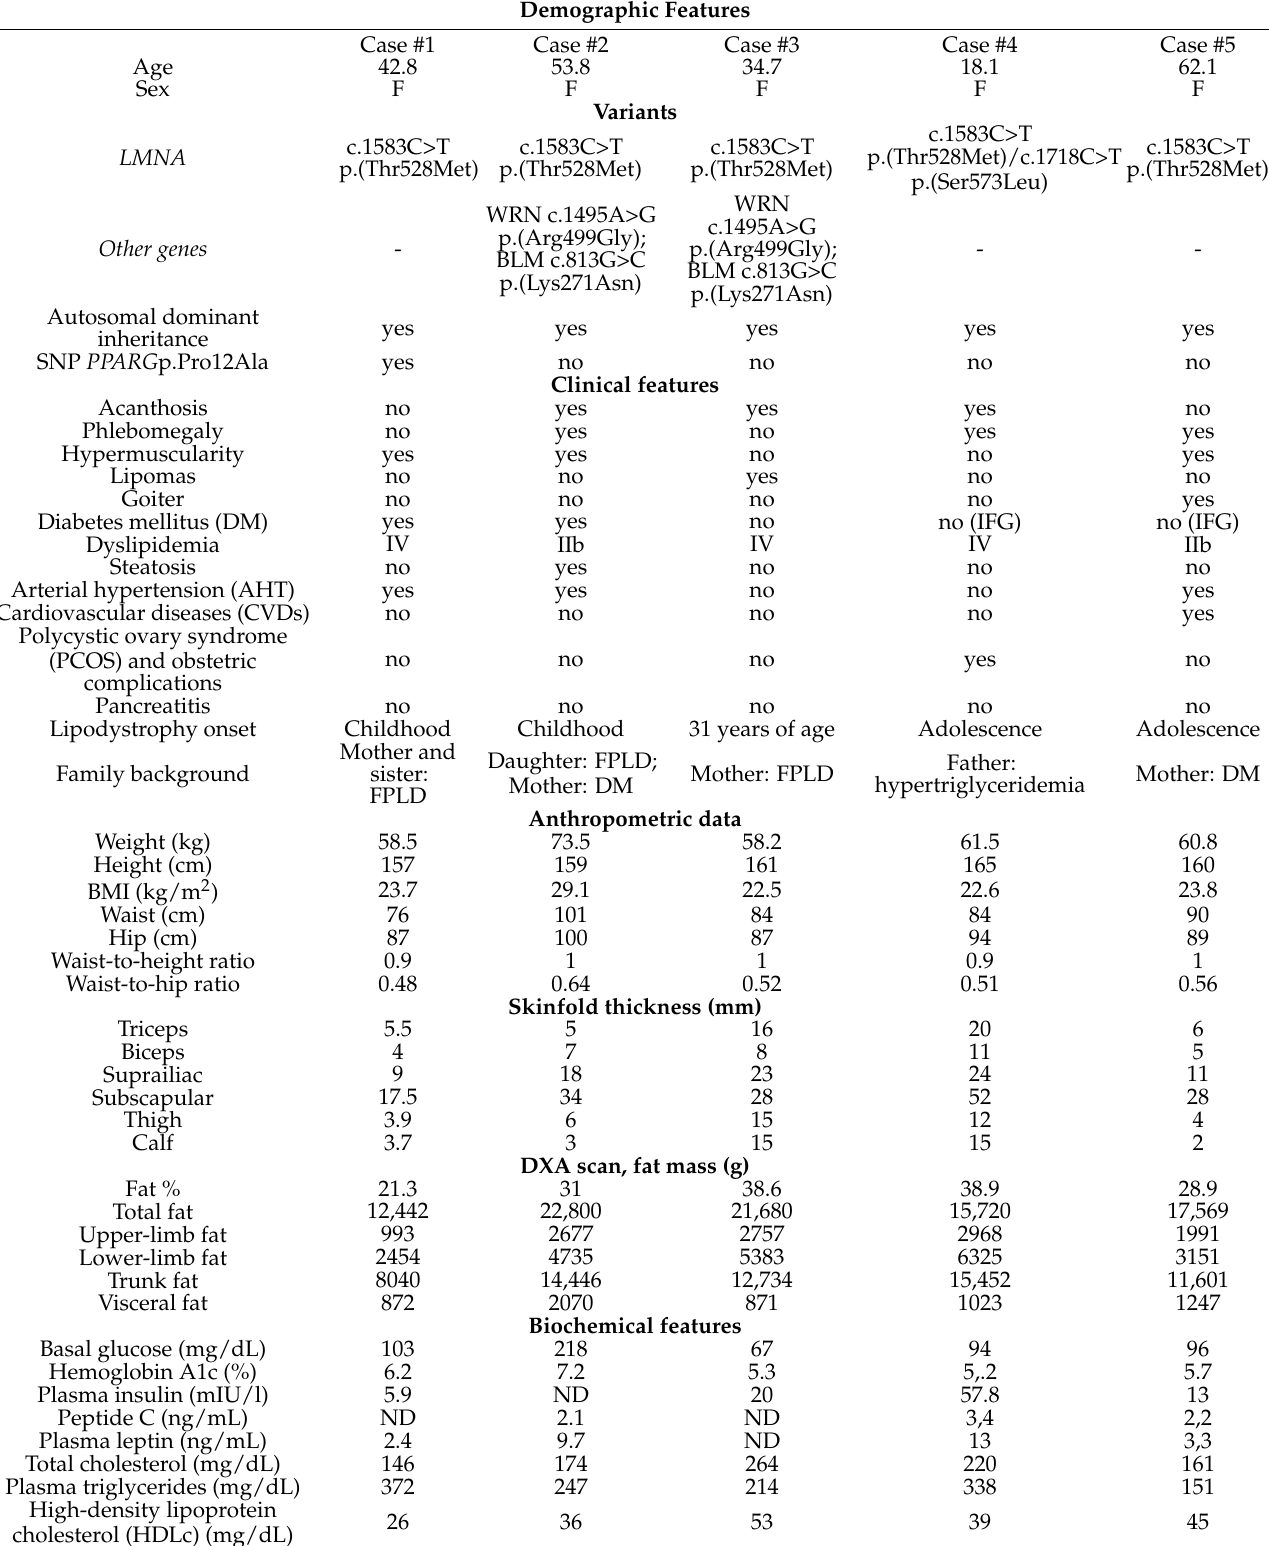
Table 2. Demographic, anthropometric, biochemical and clinical features of the studied